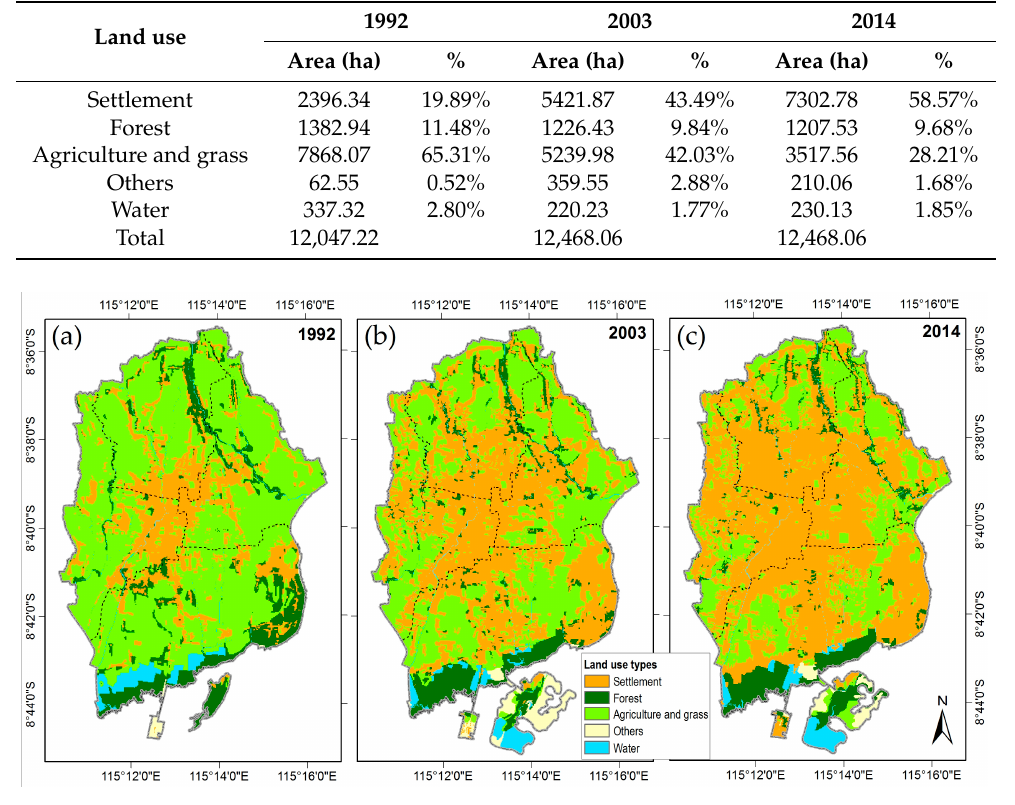
Table 3. Changes in land use types in Denpasar from 1992 to 2014 in percent and the land use expansion index (LUEI) value (% year − 1